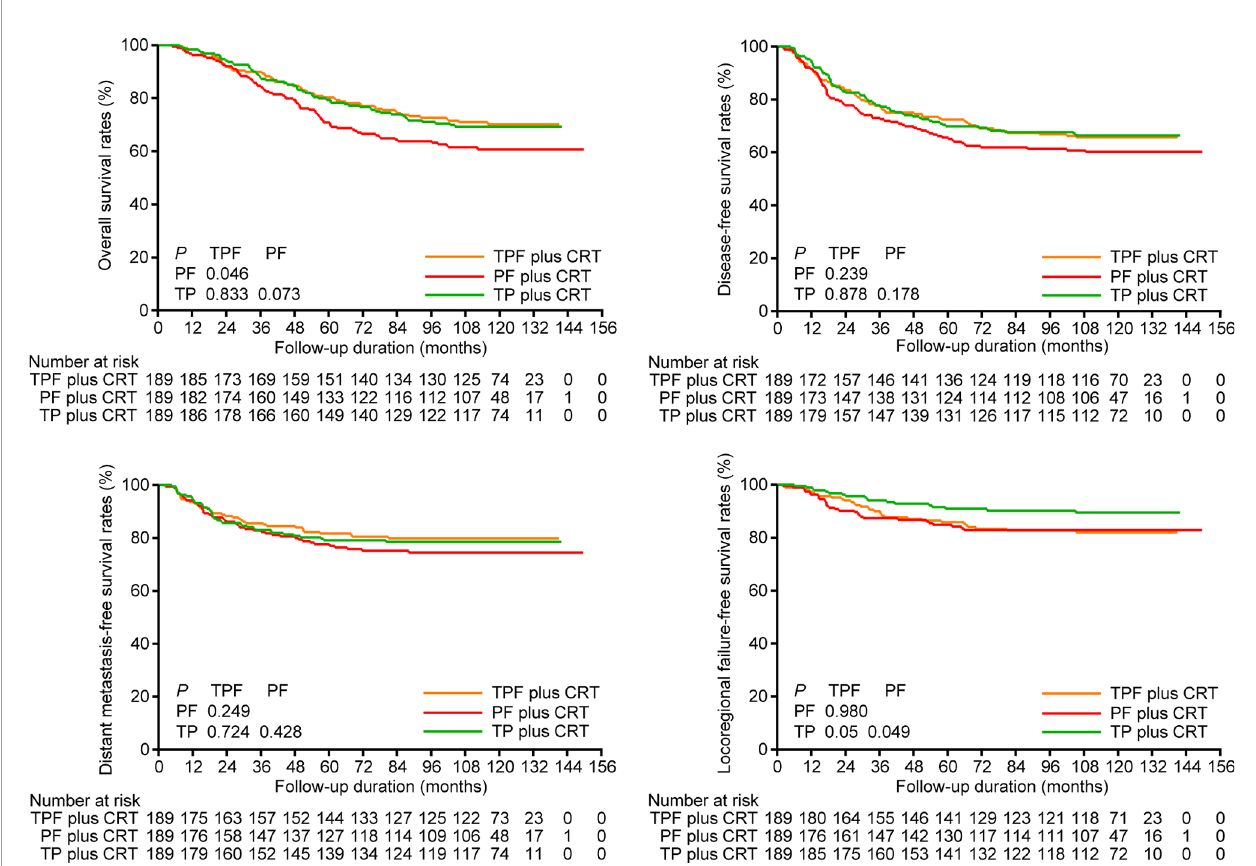
FIGURE 2 | Kaplan-Meier overall survival, disease-free survival, distant metastasis-free survival, and locoregional failure-free survival curves of patients receiving induction TPF, PF, and TP plus CRT in the 189 pairs of sensitivity analysis. TPF, docetaxel plus cisplatin and fl uorouracil; PF, cisplatin plus fl uorouracil; TP, docetaxel plus cisplatin.